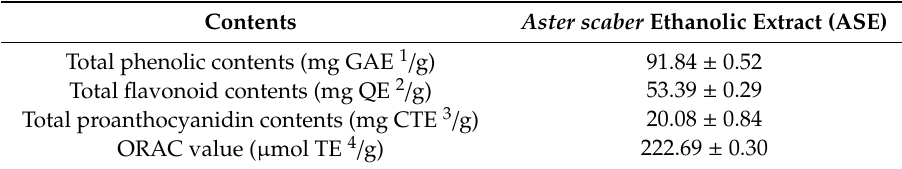
Table 1. Total phenol, flavonoid, proanthocyanidin contents, and oxygen radical absorbance capacity (ORAC) value of Aster scaber ethanolic extract (ASE).